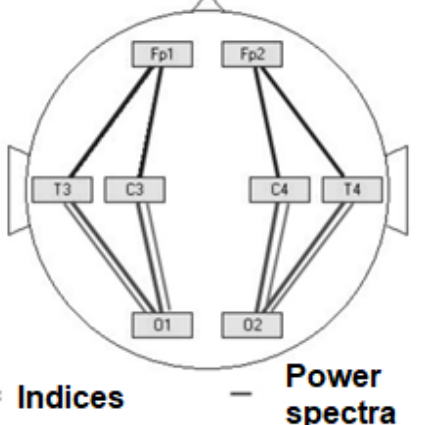
Figure 5. Localization of the identified relationships in the delta and alpha ranges.